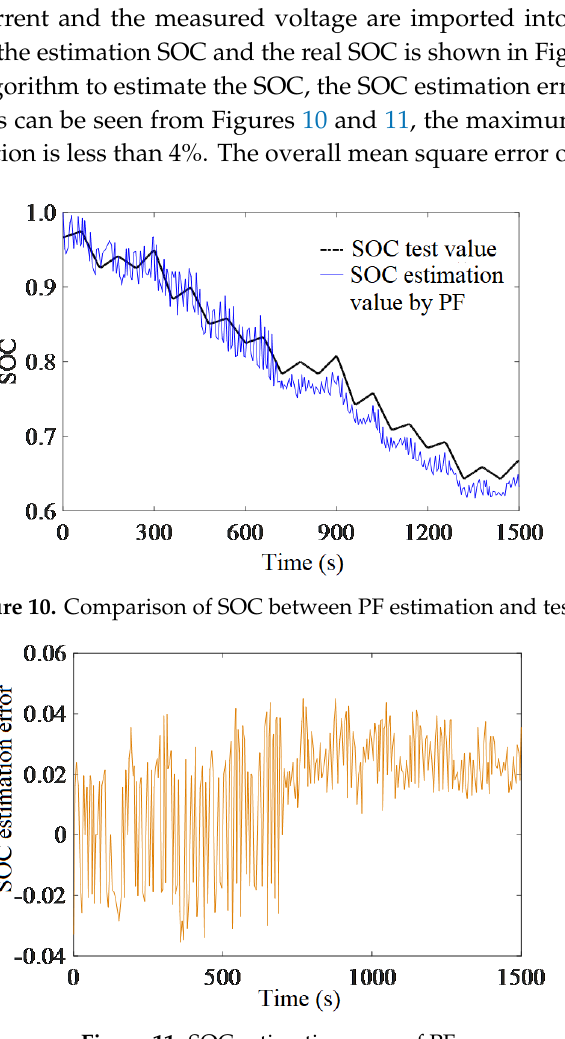
Figure 11. SOC estimation error of PF.